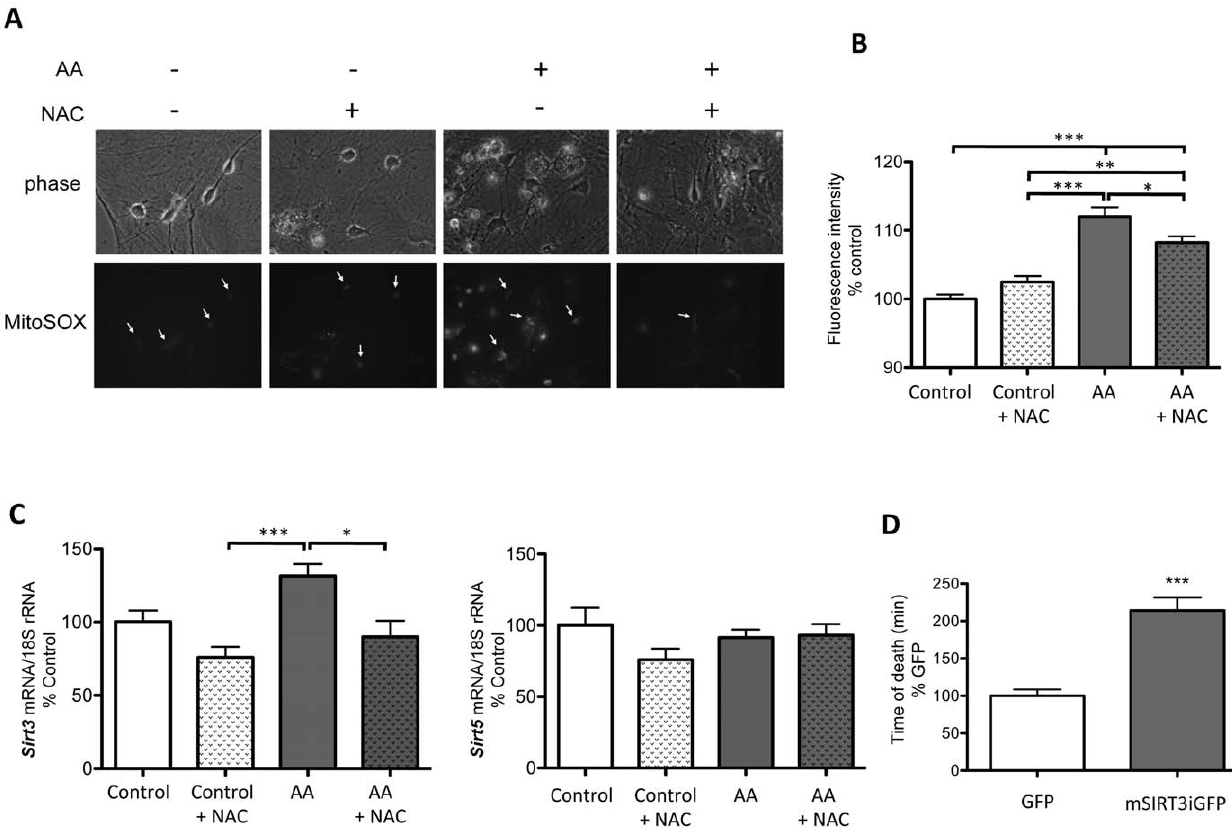
Figure 2. CNS Sirt3 mRNA expression is regulated by mitochondrial ROS and Sirt3 over-expression increases neuronal longevity. A. Primary hippocampal cultures were loaded with MitoSOX, treated with antimycin A (AA, 250 nM, 12 hr) and/or pre-treated with N-acetyl-L-cysteine (NAC, 100 m M, o/n) and phase and fluorescent still images taken at 12 hrs. B. Mitochondrial ROS is significantly increased following AA treatment, which is partially blunted by NAC (n $ 50 neurons per treatment, one-way ANOVA ***P , 0.001, **P , 0.01, *P , 0.05). C. Sirt3 , but not Sirt5 mRNA expression is upregulated in response to AA treatment in primary hippocampal cultures, which is blocked by NAC ROS scavenging (n=10). Sirt3/ 5 mRNA was measured and normalized to 18S rRNA using TaqMan multiplex QPCR. D. Sirt3 over-expression significantly increases neuronal lifespan. Hippocampal primary cultures were transduced with neuronal-specific lenti-GFP (control) or lenti-mSIRT3iGFP lentivirus and treated with AA (250 nM). Time until fluorescent neuronal death was recorded and is expressed as %control (n . 150, ***P . 0.0001).